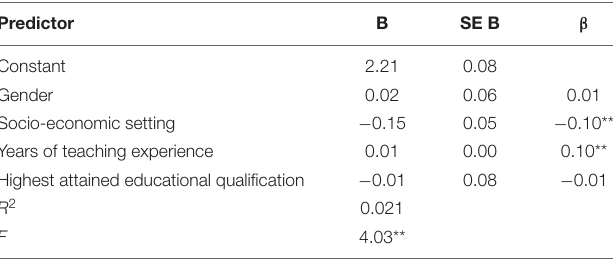
TABLE 5 | Multiple regression analysis predicting the source of mathematical knowledge belief from gender, socio-economic setting, years of teaching experience, and highest attained education